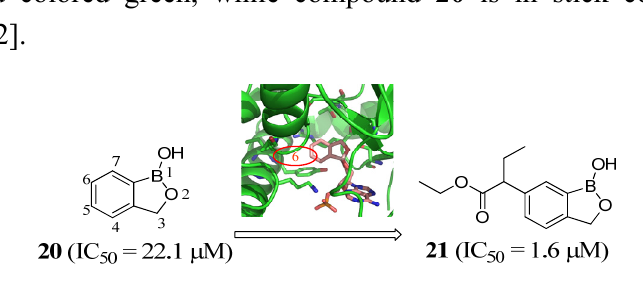
Figure 7. Structures of MetRS inhibitors with IC